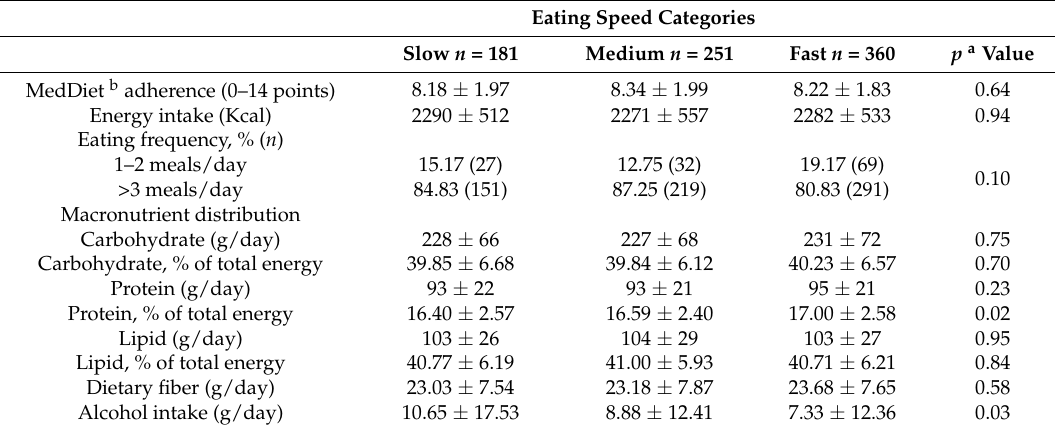
Table 2. Dietary characteristics of the study population across self-reported eating speed